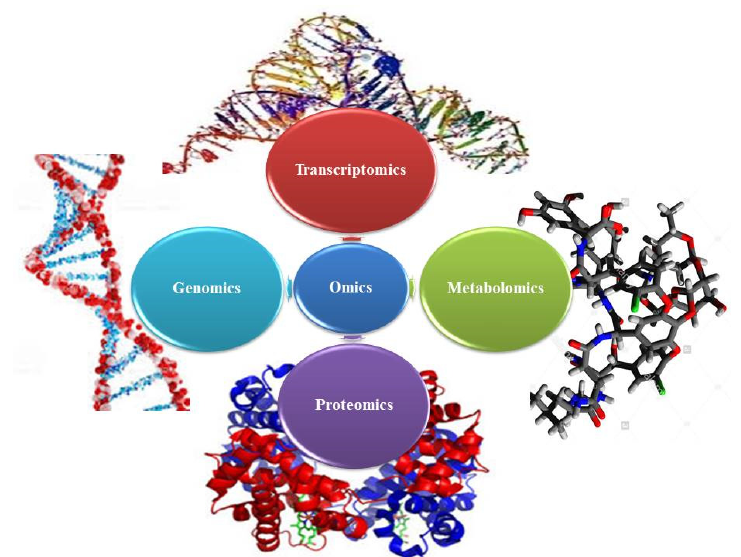
Figure 1. Omics in Medicinal Plants.